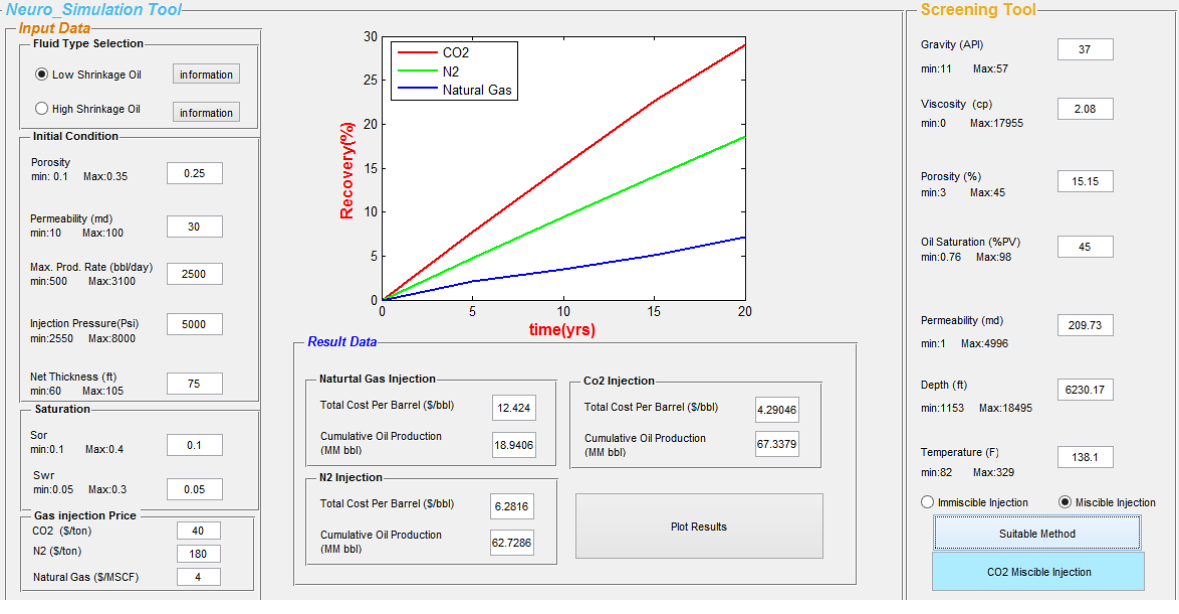
Figure 6. Main window of graphical user